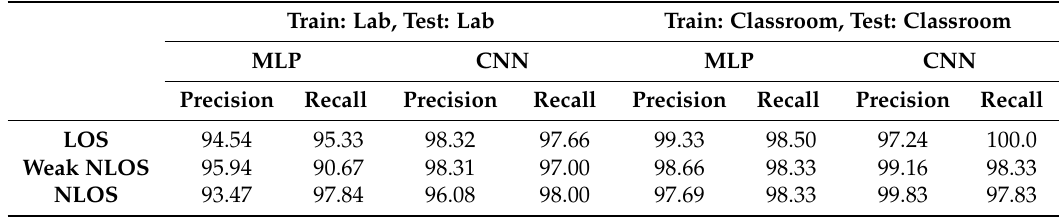
Figure 5. UWB channel classification accuracy of the MLP and CNN in the measured environment. Table 3. UWB channel classification performance on the MLP and CNN in the measured